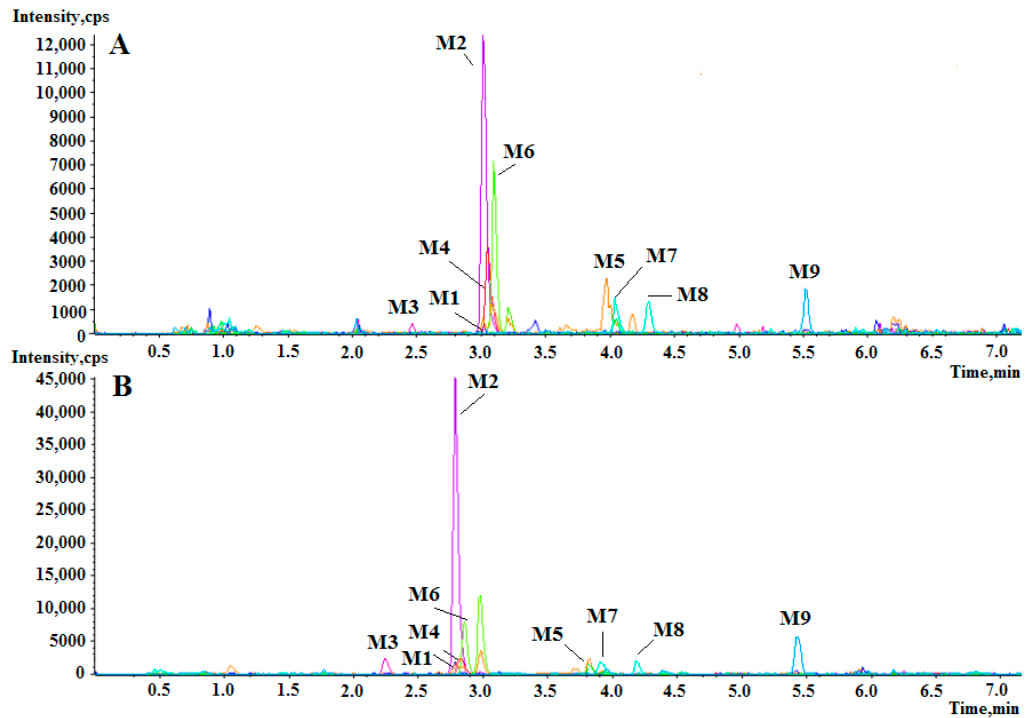
Figure 2. The extracted ion chromatogram of berberine metabolites samples. Formic acid (0.05%) in mobile phases ( A ) and 0.1% formic acid in mobile phases ( B ).